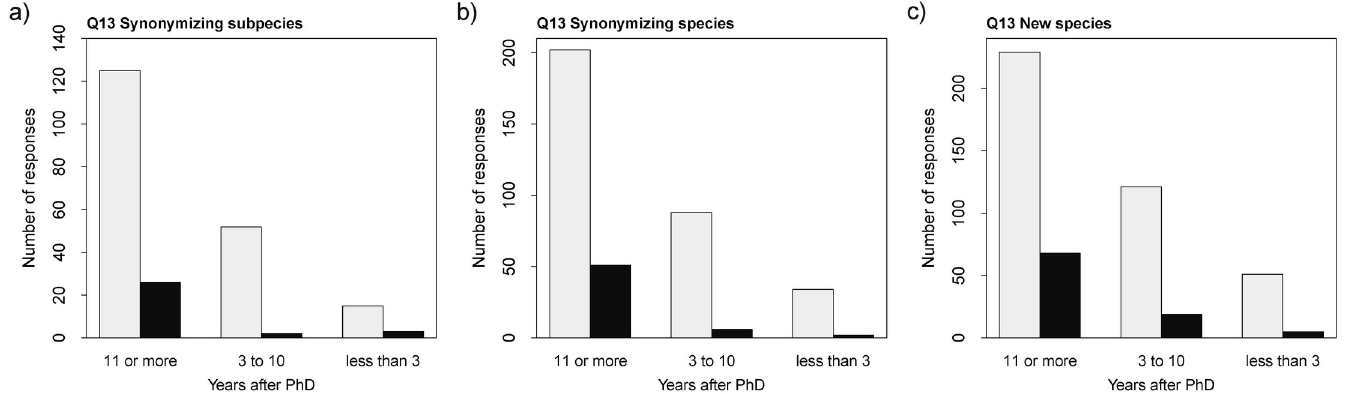
Fig 5. Responses to Q12 and Q13. Number of responses to Q12 and Q13 relative to years after PhD for different types of nomenclatural acts. Yes = black, no = light grey.